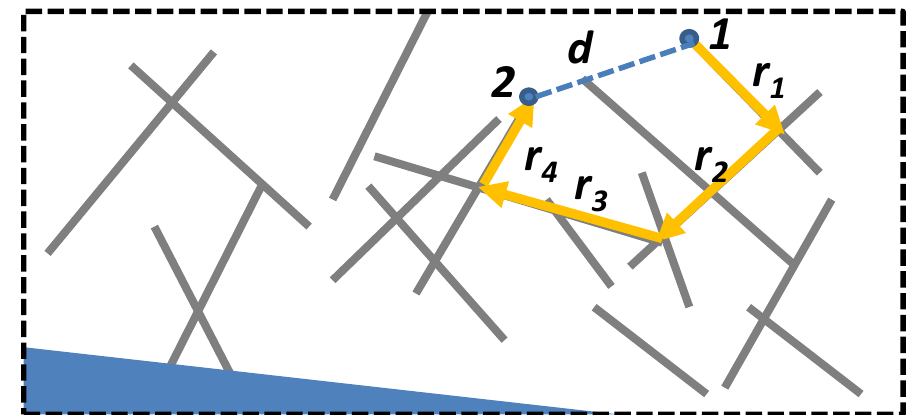
Figure 2—Illustration of the displacements with respect to different coordinates.